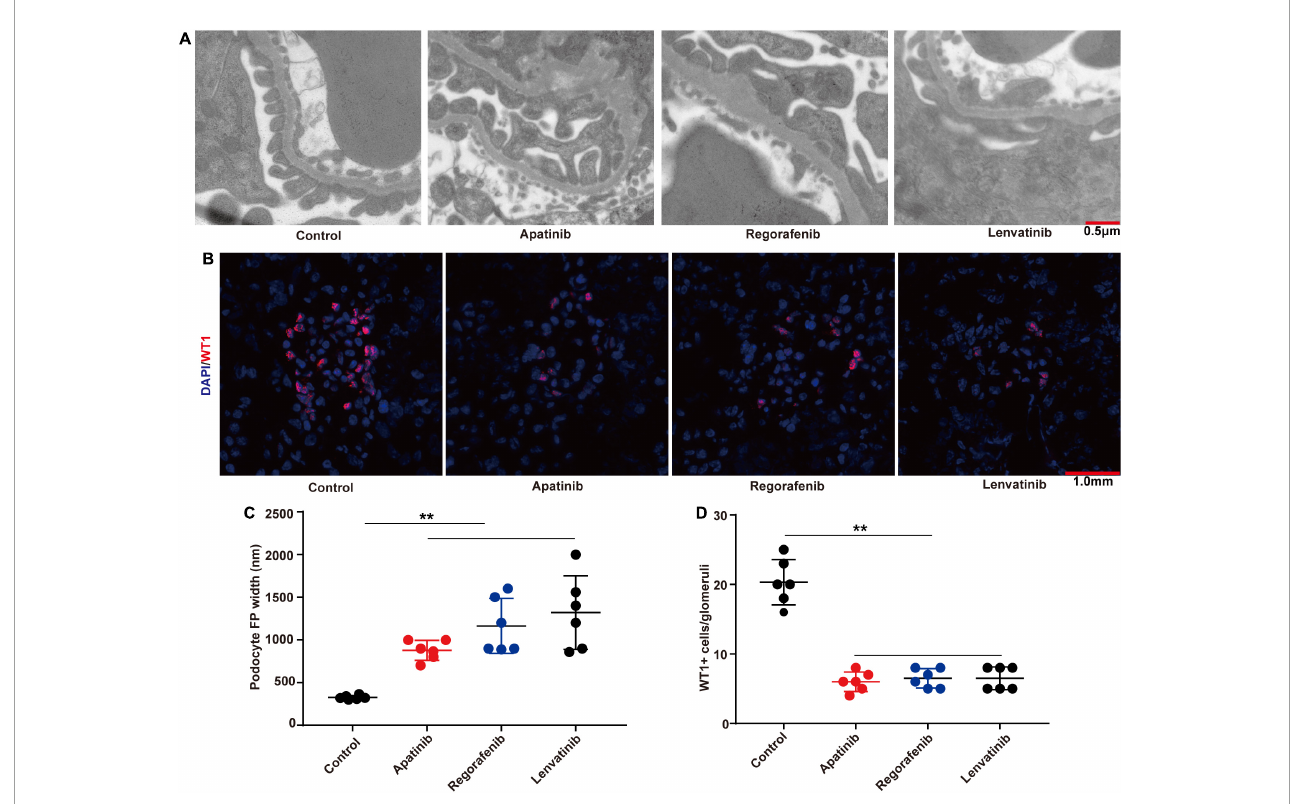
FIGURE2 TKIs treatment causes podocyte loss and foot process effacement. (A) Representative glomerular filtration barrier of mice treated with apatinib, regorafenib, and lenvatinib under a transmission electron microscope ( n = 6, each group). (B) Representative glomerular WT-1 staining of mice treated with apatinib, regorafenib, and lenvatinib. 12 fields were randomly selected for WT-1 + staining quantification ( n = 6 in each group). (C) The distribution width of podocytes in each group. (D) WT-1 expression in each group, ** p < 0.01.